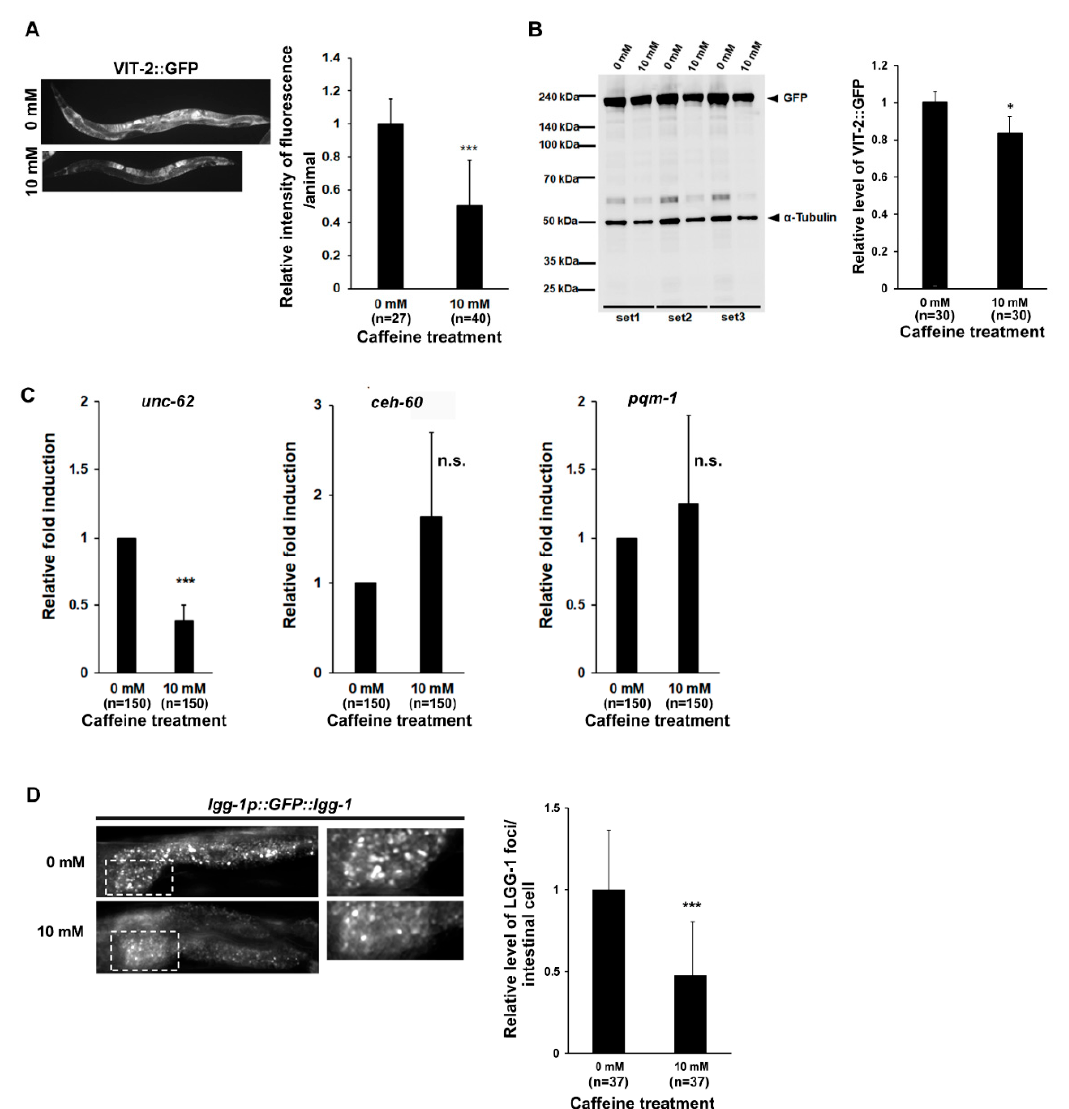
Figure 2. Long-term caffeine intake decreases vitellogenesis in advanced ages of C. elegans : ( A ) Animals expressing vitellogenin (VIT)-2::GFP were treated with 0 or 10 mM caffeine at the L4 stage at 25 ◦ C for 72 h. The expression of VIT-2::GFP was observed at 72 h in post-L4-stage animals at 25 ◦ C. Error bars represent SD. *** p < 0.001 ( t -test); ( B ) Western blot analysis of VIT-2::GFP protein levels using an anti-GFP antibody in each test condition. α -tubulin was used as the loading control. The relative expression levels of GFP in each condition are shown. GFP band intensity was normalized to that of α -tubulin on the same lane, and the relative levels of GFP were converted to a relative value against that of the animals fed with 0 mM caffeine as 1. Error bars represent SD. * p < 0.05 ( t -test); ( C ) The synchronized wild-type L4-stage animals were treated with 0 or 10 mM caffeine at 25 ◦ C for 72 h. The mRNA levels of unc-62 , ceh-60 , and pqm-1 in the caffeine-free or caffeine-ingested animals were determined by three independent quantitative reverse transcription-polymerase chain reaction (qRT-PCR) tests using the mRNA level of act-1 in each sample as an internal control for normalization. Error bars represent SD. *** p < 0.001. n.s., not significant ( t -test); ( D ) Animals expressing lgg-1p::GFP::lgg-1 were treated with 0 or 10 mM caffeine at the L4 stage at 25 ◦ C for 72 h; then, we imaged GFP::LGG-1 foci in the intestinal cells at 72 h post-L4-stage animals at 25 ◦ C. The white dotted box represents the GFP::LGG-1 foci in the intestinal cells, and the right panel shows an enlarged image. The graph shows the relative levels of GFP::LGG-1 foci in the intestinal cells after caffeine treatment. Error bars represent SD. *** p < 0.001. n.s., not significant ( t -test).